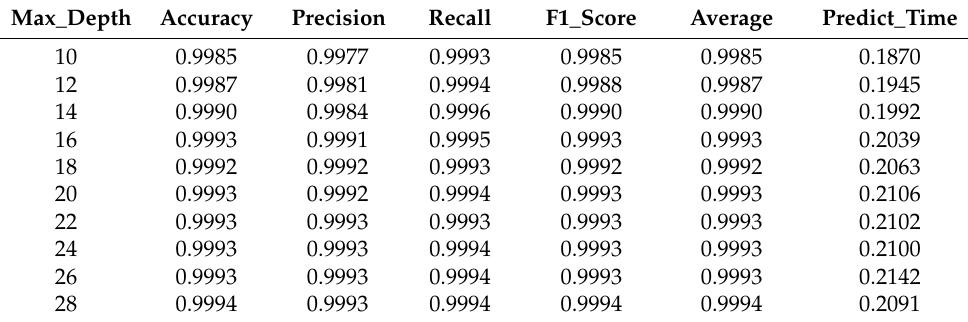
Table 8. max_depth optimization performance